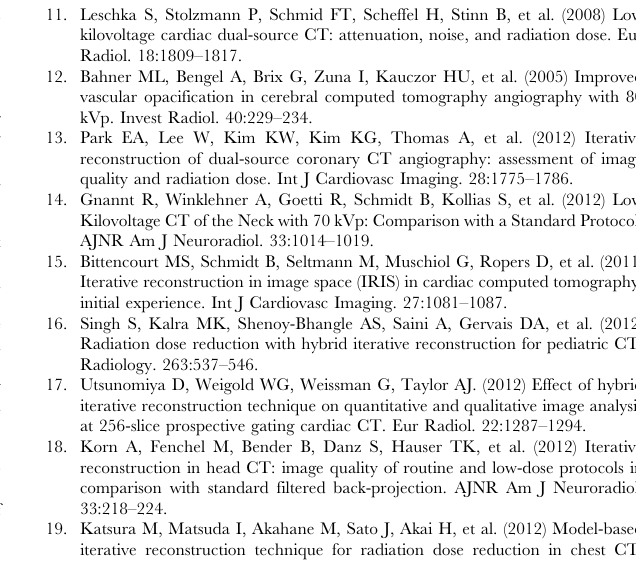
algorithm. The combination of low-tube-voltage DSCT angiog- raphy with the SAFIRE algorithm in children with CHD is recommended.